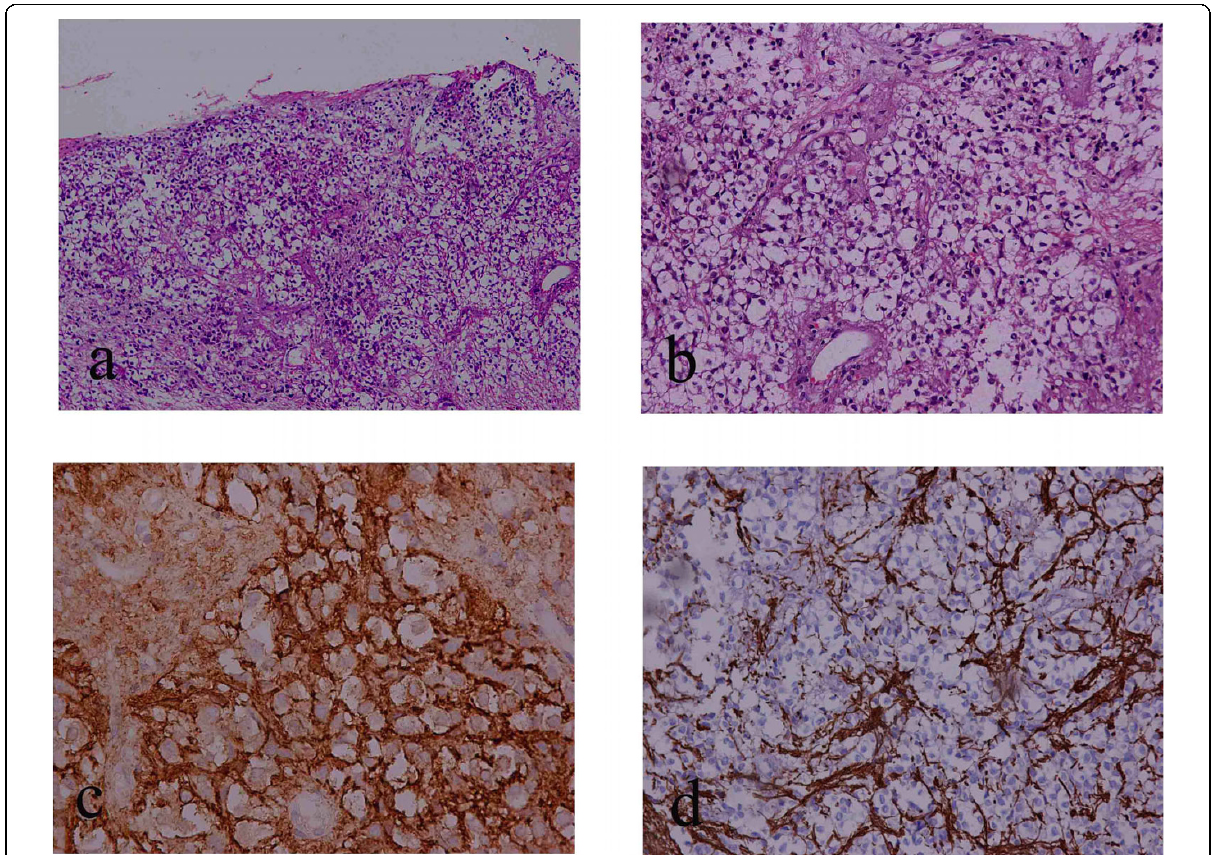
Figure 2 a. Section showing the presence of neoplastic cells with swollen clear cytoplasm within the cystic wall (MX100) . b. The neoplastic cells had a centrally located round nucleus with open chromatin, a perinuclear halo and did not display any pleiomorphism (MX400). c. d. The tumour cells were positive for CD57 and negative for GFAP